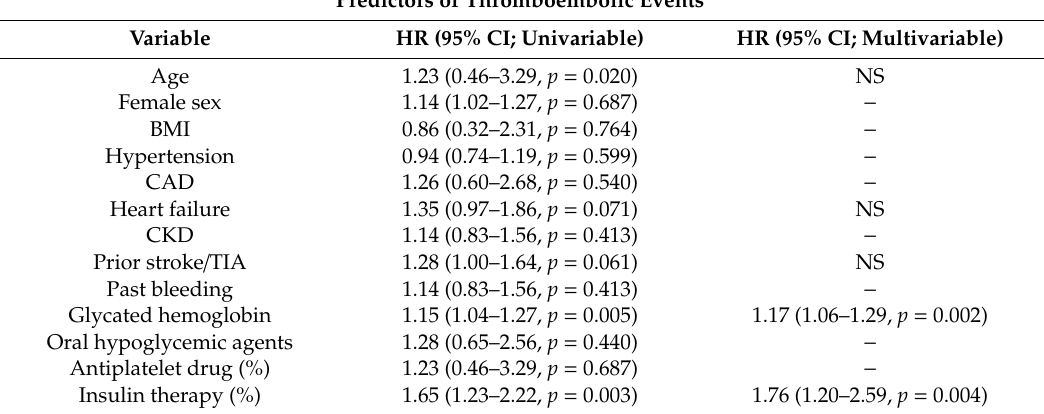
Table 3. Univariate and multivariate analysis results for variables determining the development of thromboembolic